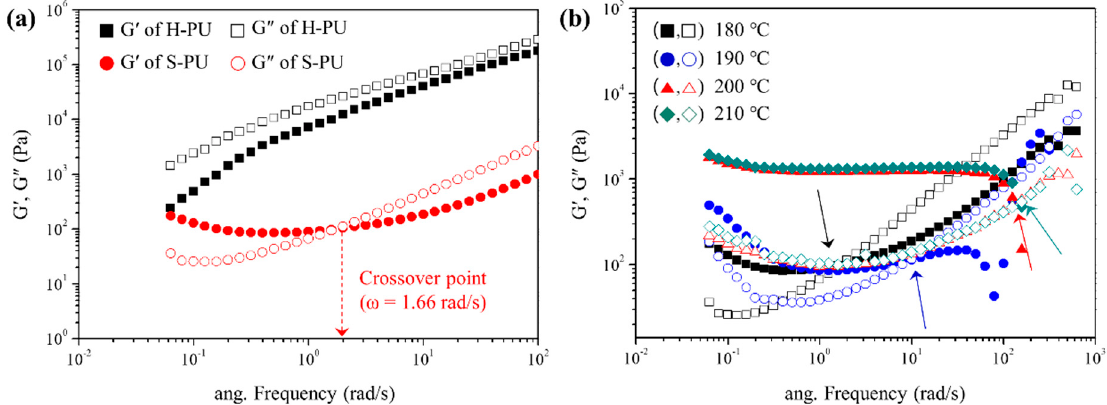
Figure 6. Rheological properties of S-PU and H-PU: ( a ) Storage moduli ( G ′ , filled symbols) and loss moduli ( G ″ , open symbols) versus angular frequency of S-PU (red) and H-PU (black) at 180 °C; ( b ) G ′ and G ″ versus angular frequency of S-PU at 180 °C, 190 °C, 200 °C and 210 °C. Table 3. Angular frequencies of G ′ -to- G ″ crossover in S-PU and H-PU at different temperatures. S-PU